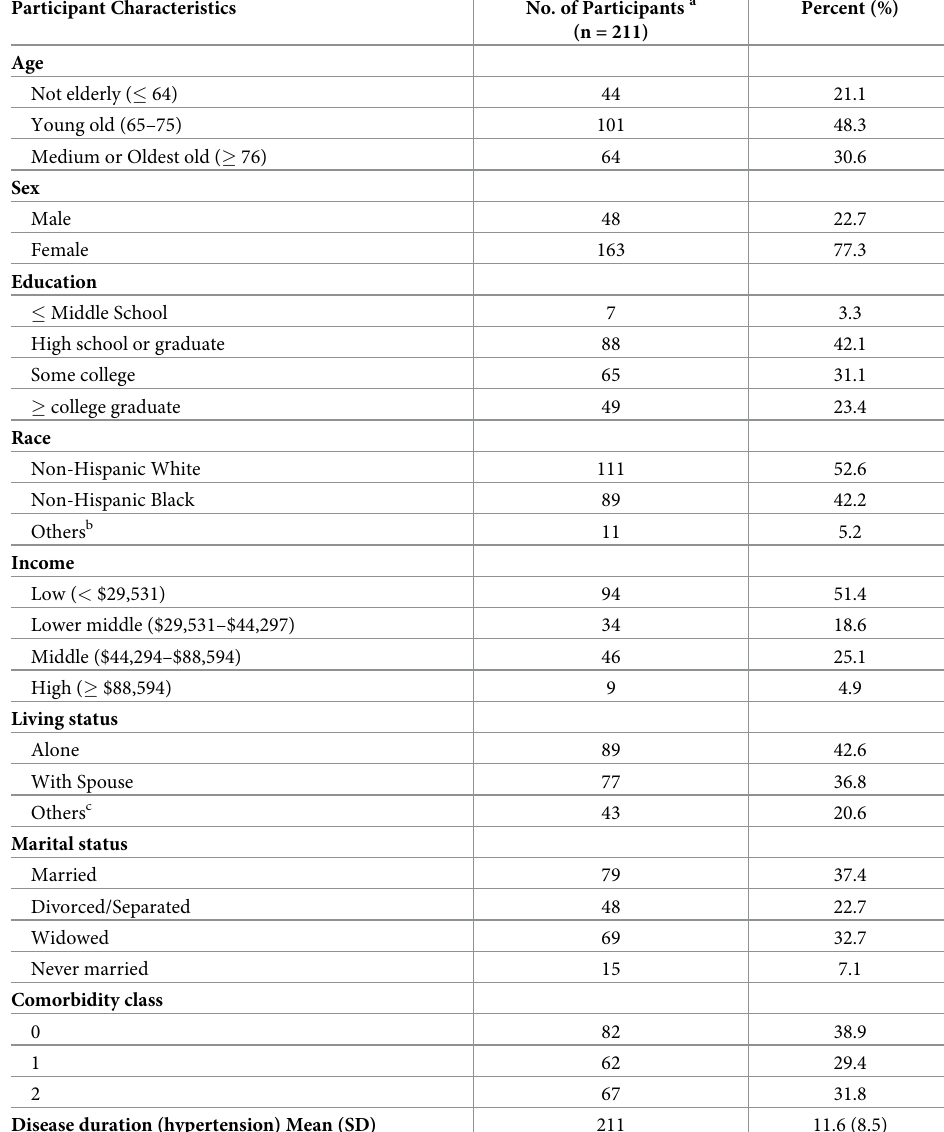
Table 2. Description of study participants. Participant